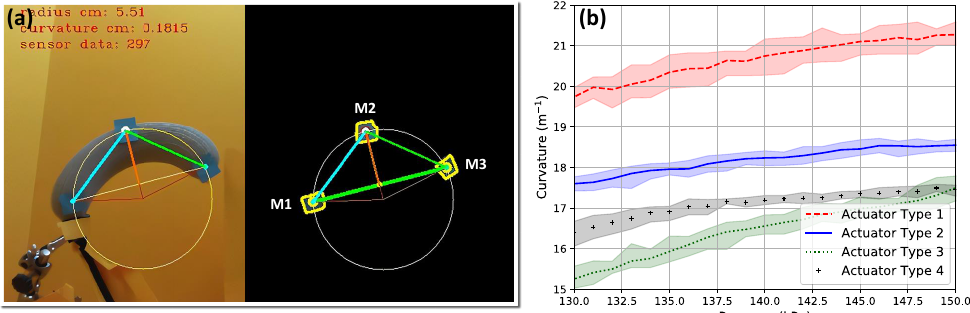
Figure 2. ( a ) Curvature measurement using a video frame. ( b ) Curvature of the seamless knitted actuators at different